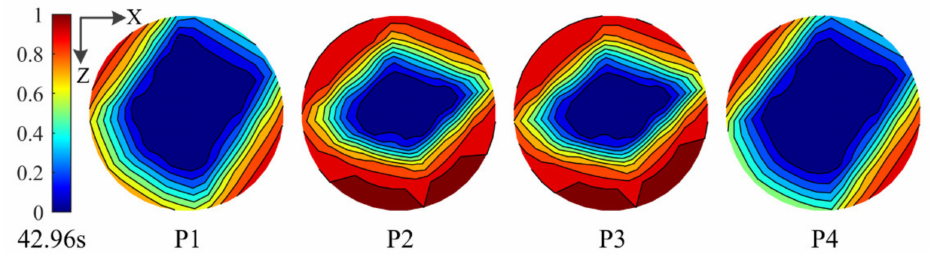
Figure 17. The compression damage of concrete in the core area at 42.96